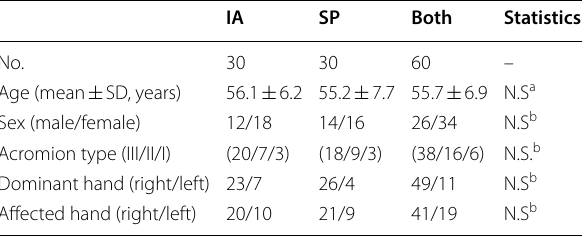
characteristics and